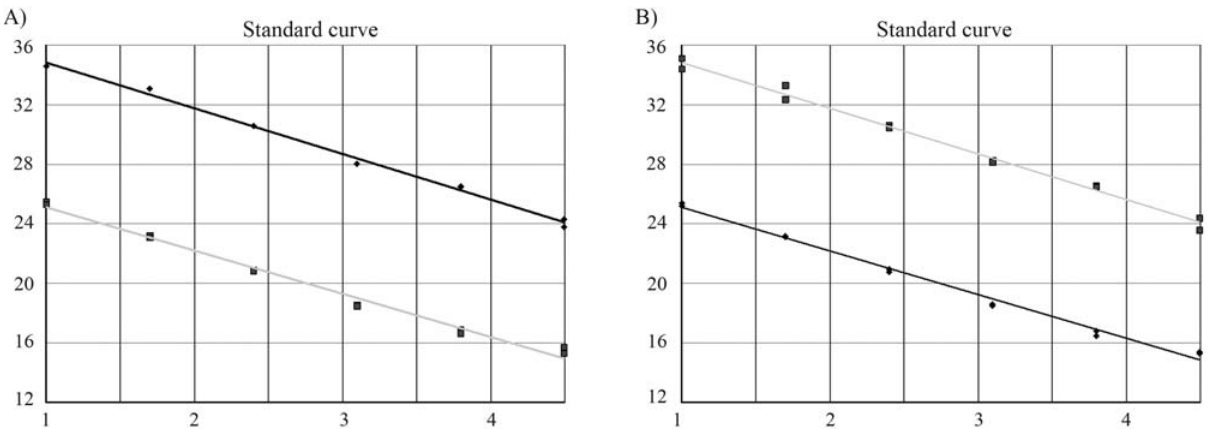
Figure 1 - Simulation of real-time PCR kinetics for amplifying mtDNA and nDNA on serial dilutions. The figure shows reproducible standard dilution curves for identification of the mtDNA and nDNA. The upper lines are nDNA standard dilution curves and the lower lines are mtDNA standard dilution curves. The numbers on the y axis represent the values of cycle threshold (Ct) and numbers on the x axis represent the dilution